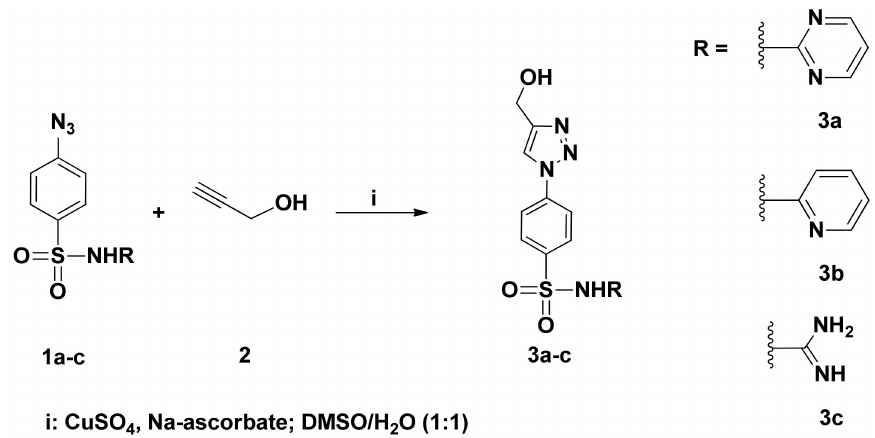
Scheme 1. Click synthesis of 1,2,3-triazoles with sulfa-drug tethers 3a – c .